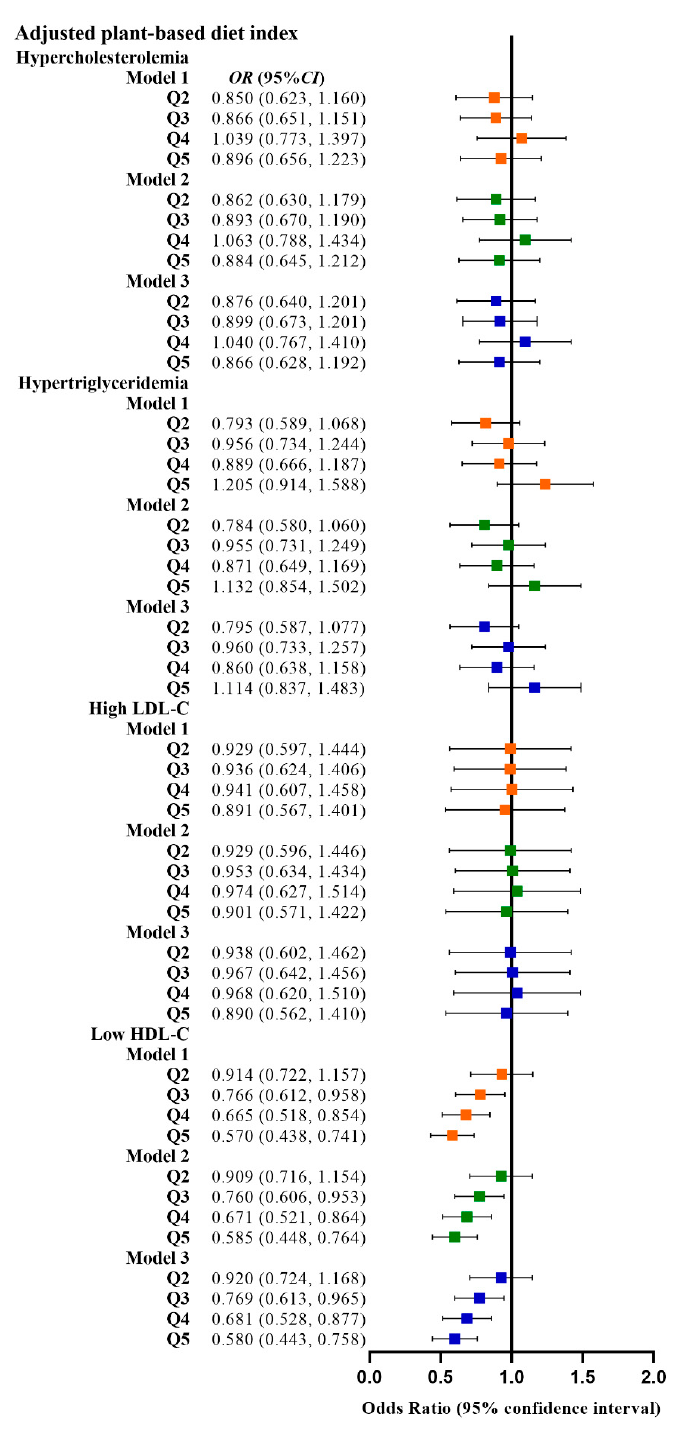
Figure 5. Odds ratios (OR) and 95% confidence intervals (CI) for aPDI with different types of dyslipidemia. The squares show odds ratios and the line ranges show 95% confidence intervals. Model 1: unadjusted; model 2: adjusted for sex, age, ethnicity, BMI, socio-economic status, smoking status, alcohol consumption, and physical activity; model 3: additionally adjusted for T2DM and hypertension.